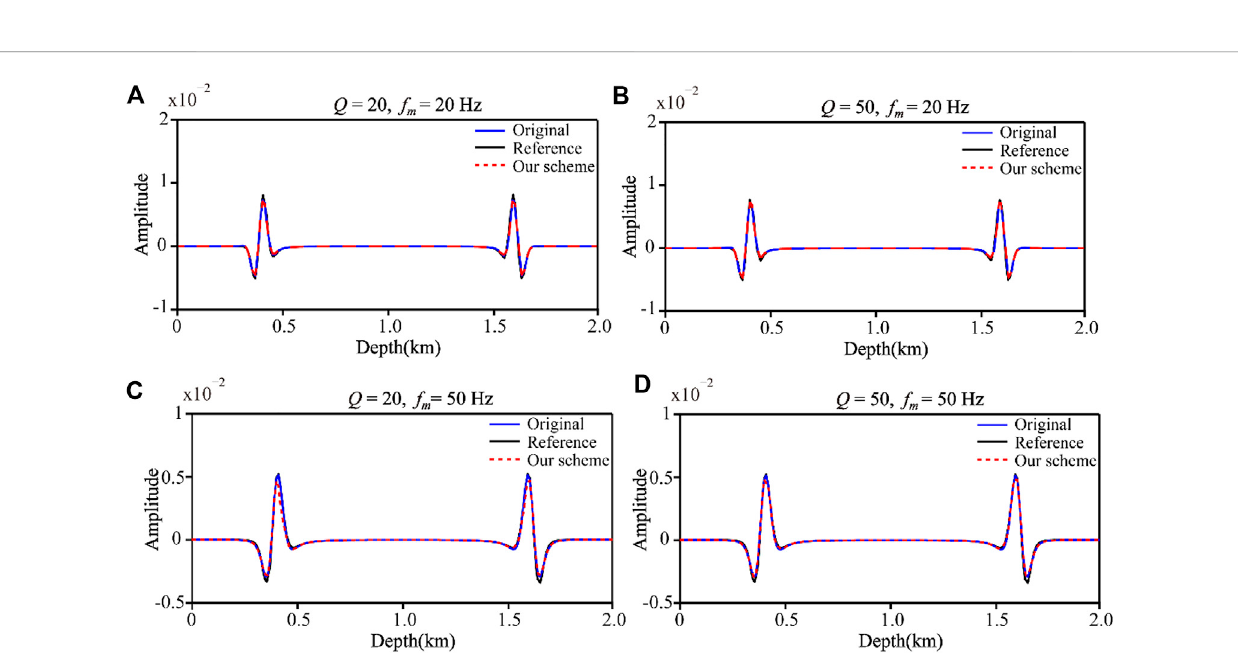
FIGURE 2 Single trace at ( x = 1 km) with different wave equations. (A) Q (cid:1) 20 , f m (cid:1) 20; (B) Q (cid:1) 50 , f m (cid:1) 20; (C) Q (cid:1) 20 , f m (cid:1) 50; (D) Q (cid:1) 50 , f m (cid:1) 50.